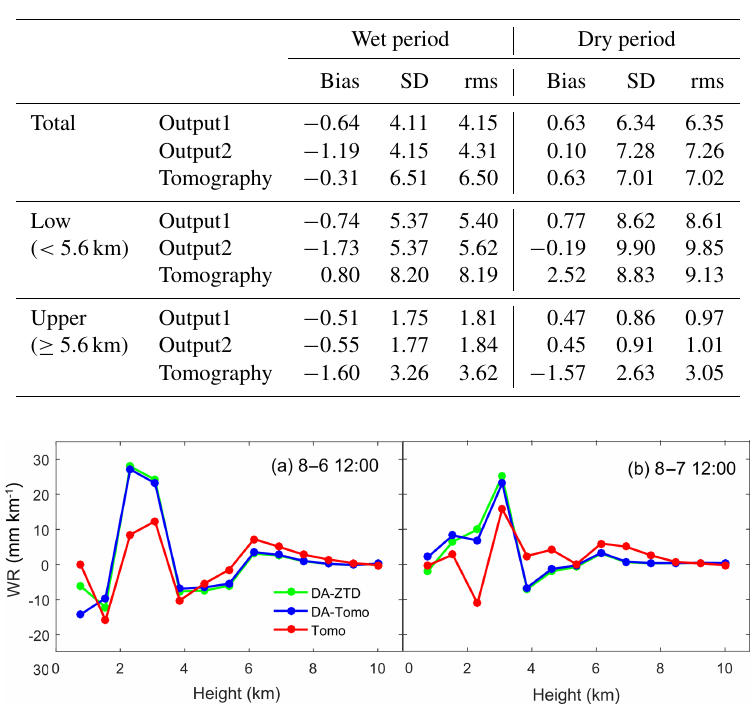
Table 2. Statistics of bias, rms and SD of tomography, Output1 and Output2 validated by the radiosonde WR. Unit is mmkm − 1 .